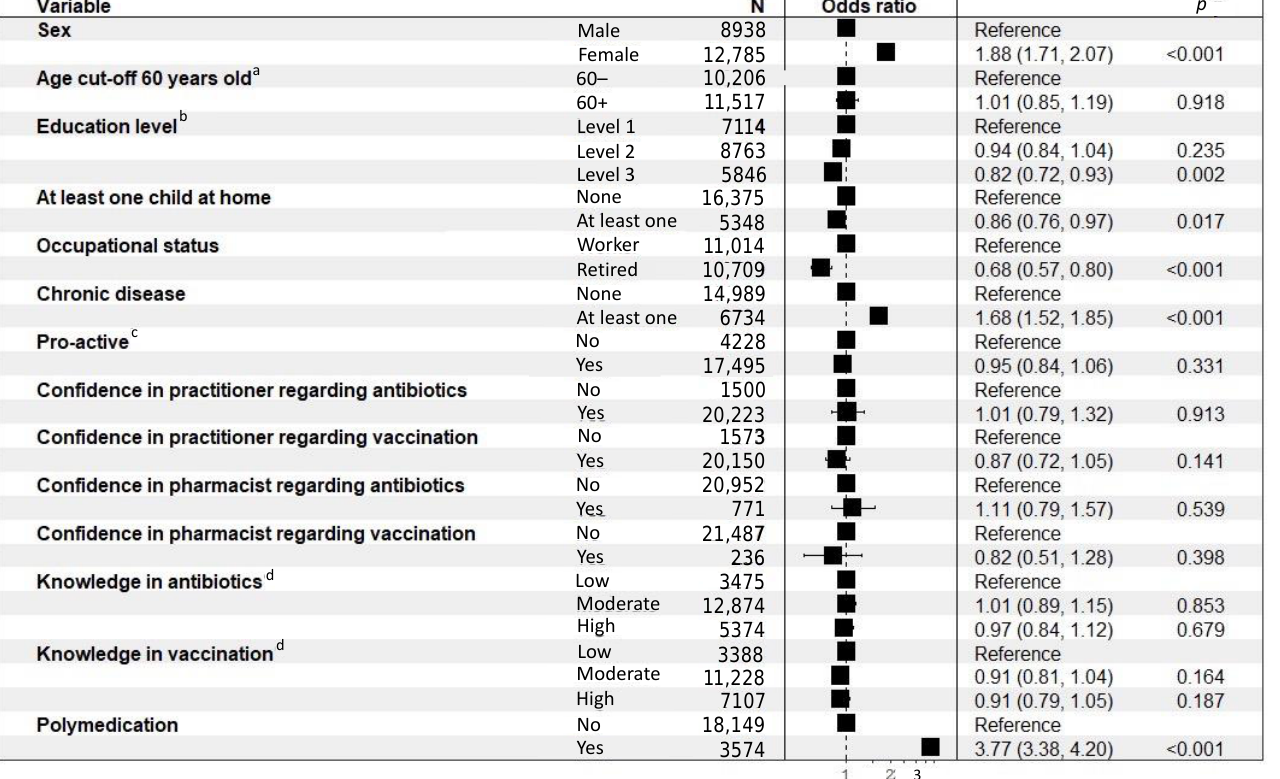
Figure 4. Binary logistic regressions performed to evaluate the determinants of daily anxiolytic or hypnotic treatments. a The age cut-off was determined at 60 years old to have homogenous age range; b Level 1: Level of education below “Baccalaureate” (French high school diploma) degree, Level 2: Level of education greater than or equal to “Baccalaureate” degree and less than or equal to “Baccalaureate” degree plus 2 years, Level 3: Level of study higher than “Baccalaureate” degree plus 2 years; c Proactive: ((asks physician for antibiotics) OR (if taking meds, has already discussed it with physician/pharmacist on own initiative) OR (if med for better sleep, has already tried non-medication methods) OR (if medication for anxiety, has already tried non-medication methods)), d Low: 0 or 1 right answer, Moderate: 2 or 3 right answers, High: 4 right answers.